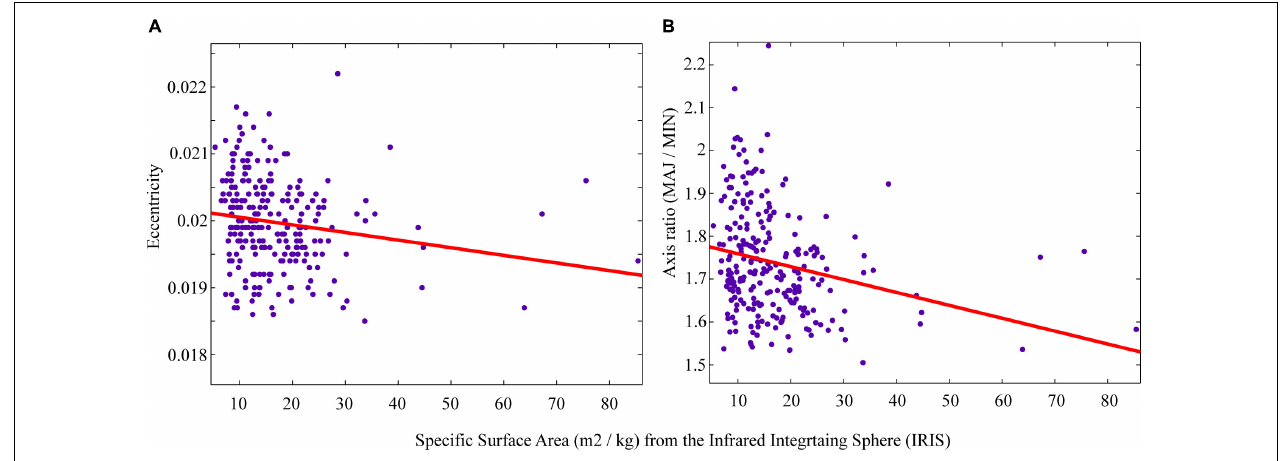
FIGURE 8 | Measured SSA values compared with (A) eccentricity and (B) axis ratio computed from the dLED.